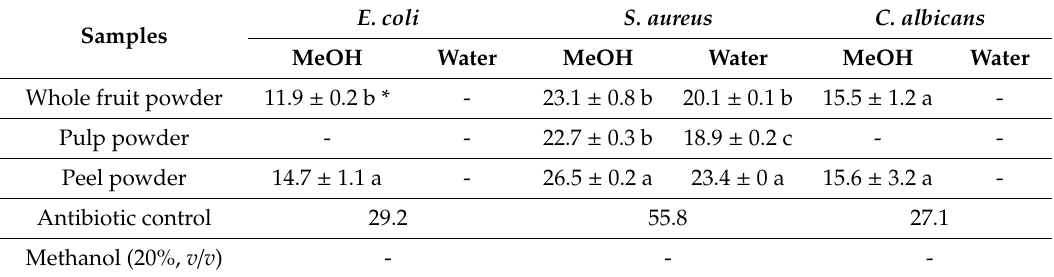
Table 7. Inhibition zones of the methanolic and water extracts from di ff erent tissues of feijoa fruit.